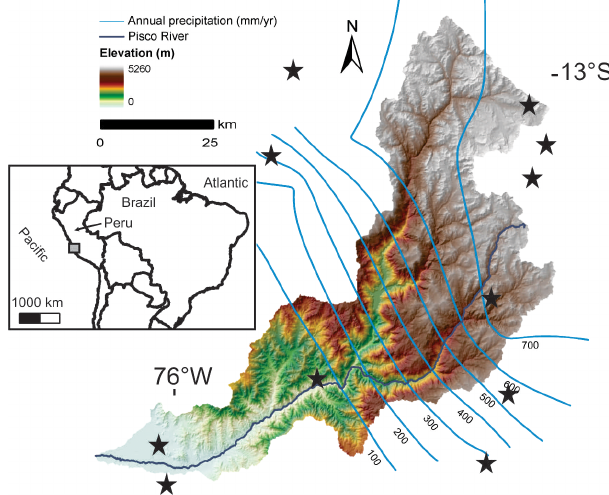
Figure 1. Setting and geomorphology of the Pisco river. Precip- itation stations used to interpolate the annual rainfall are starred (Agteca, 2010).